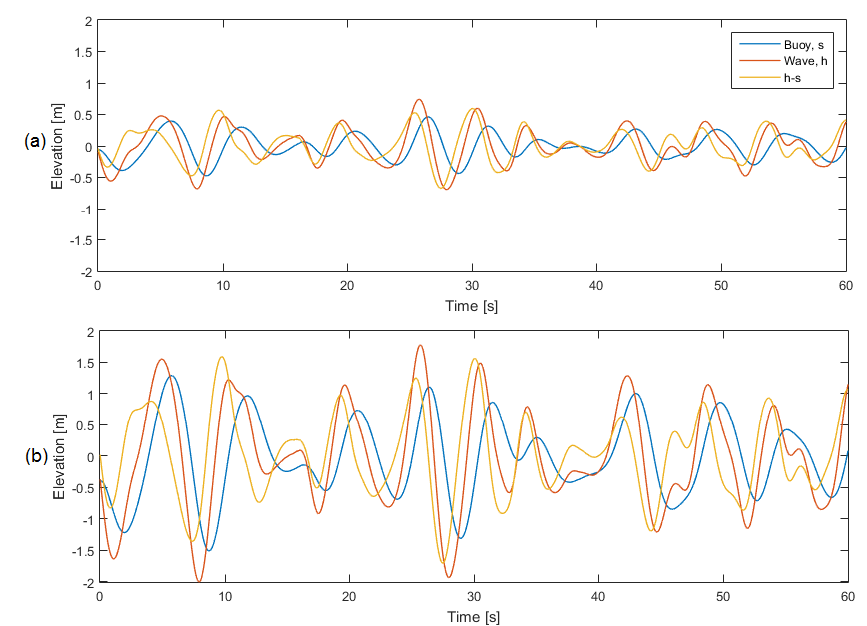
Figure 7. ( a ) Wave1; ( b ) Wave2. Blue indicates the vertical position of the cylindrical buoy. Red indicates the wave, h , inside the chamber. Yellow indicates the relative vertical position between wave, h , and cylindrical buoy, s